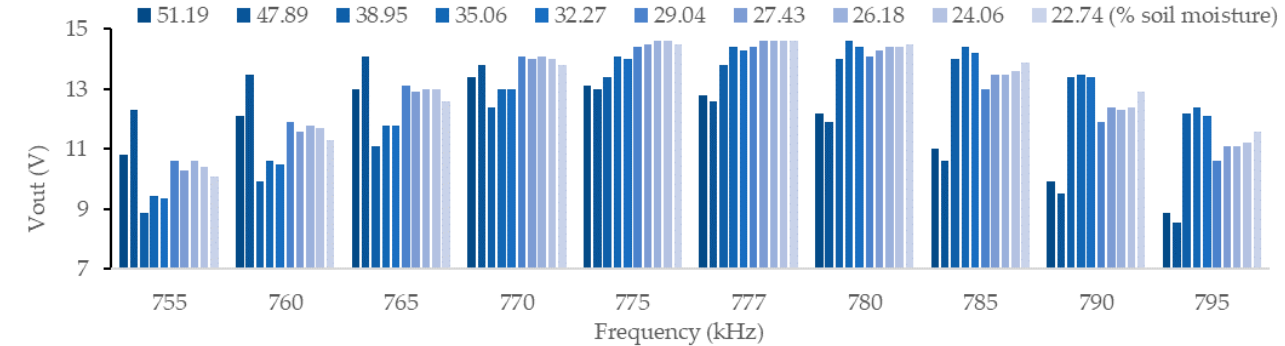
Figure 13. Vout of P8 using S3.